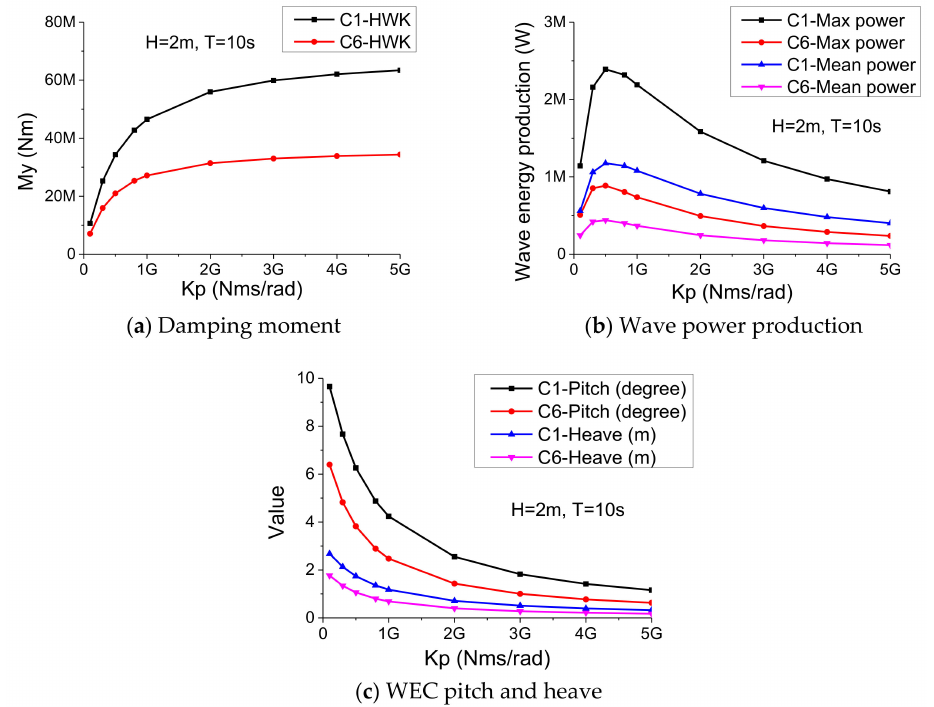
Figure 7. Effect of different pitch damping levels on WEC modules’ motions: ( a ) Damping moment, ( b ) wave power production, ( c ) WEC pitch and